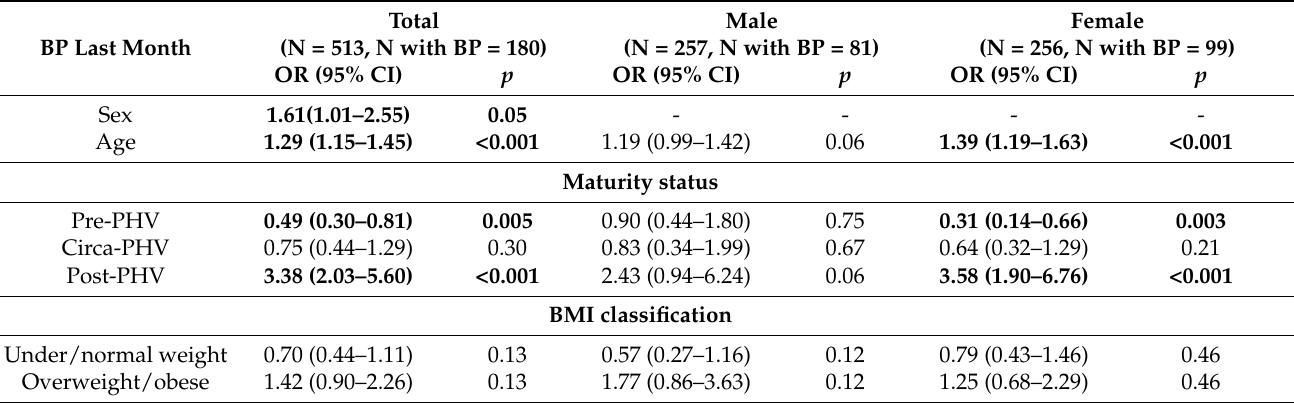
Table 3. Back pain in the last month and possible risk factors for the total sample and by